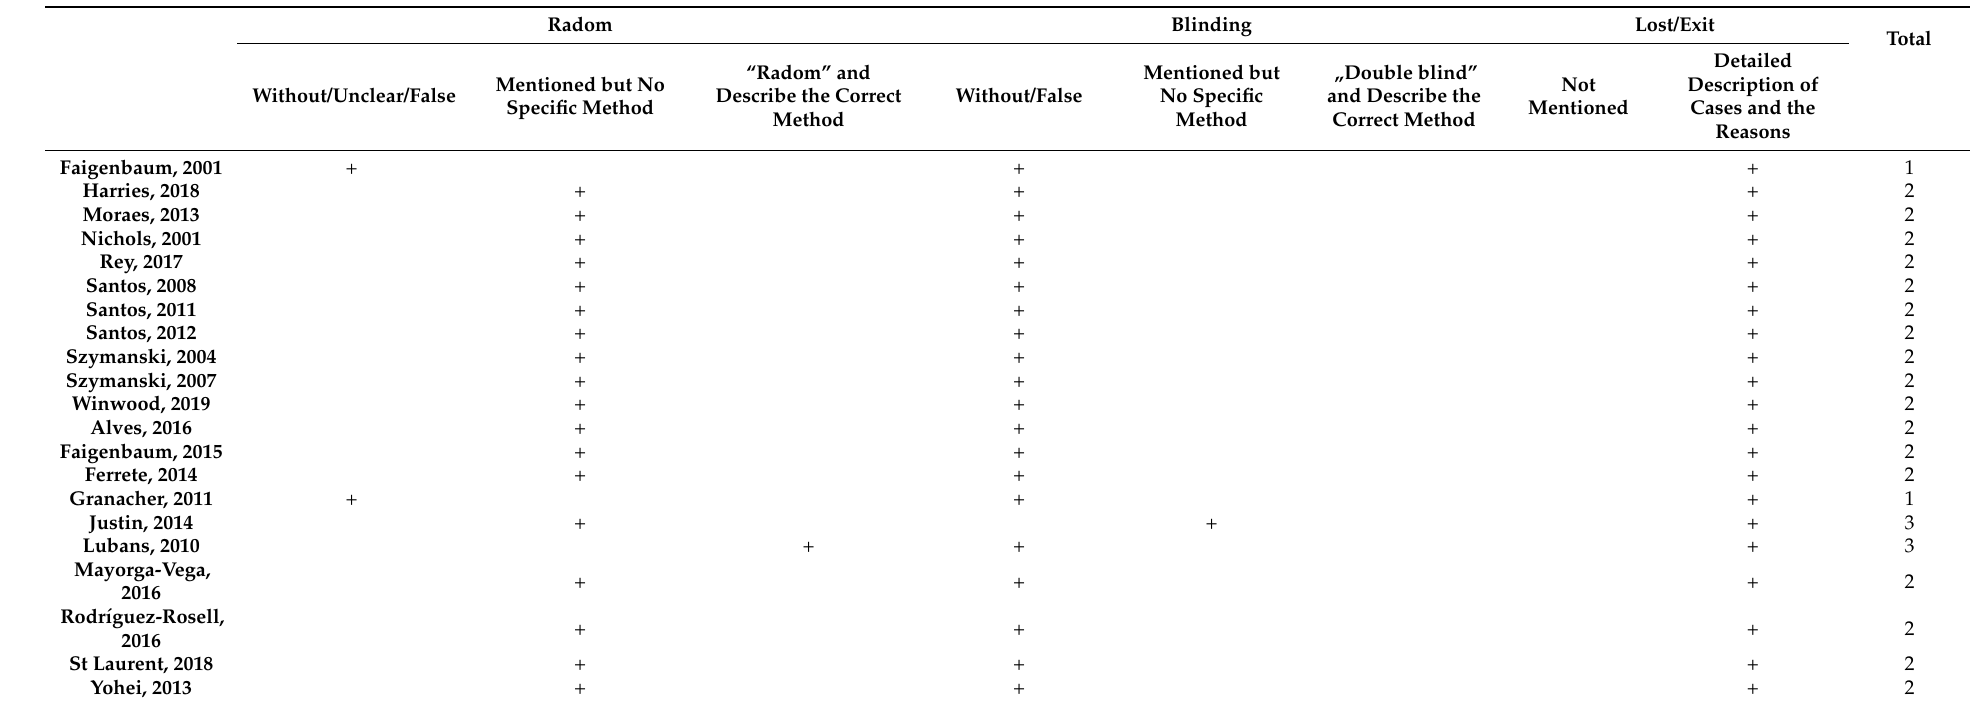
Table 2. Jadad scores of the reviewed